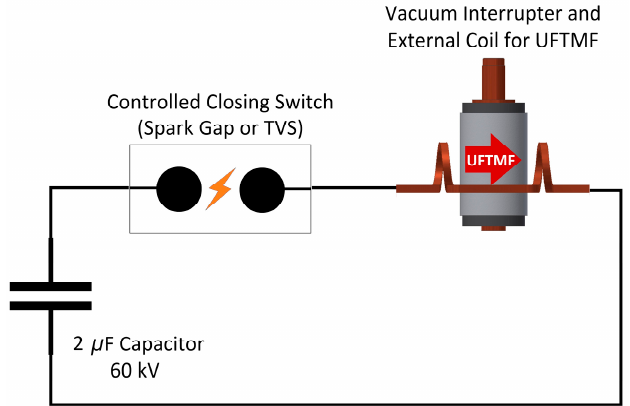
Figure 9. Schematic diagram of an electric current feeding circuit.